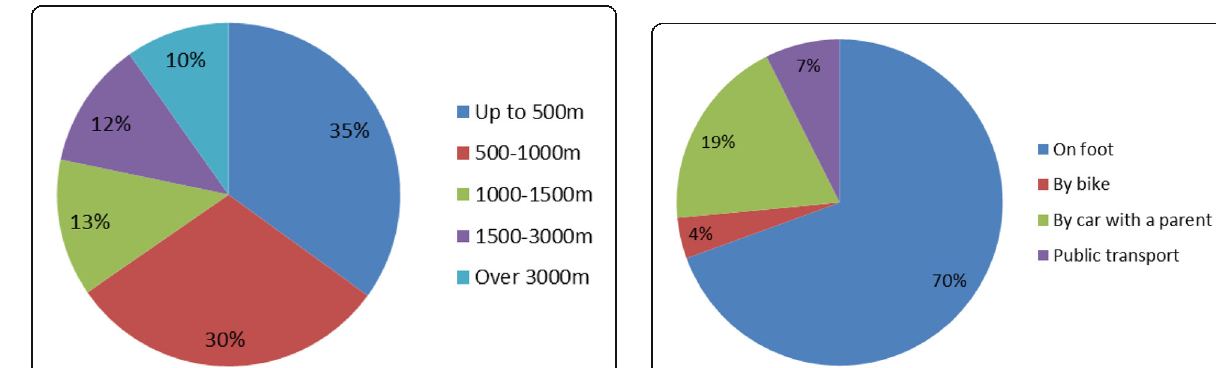
Fig. 10 The children ’ s everyday way of getting from home to